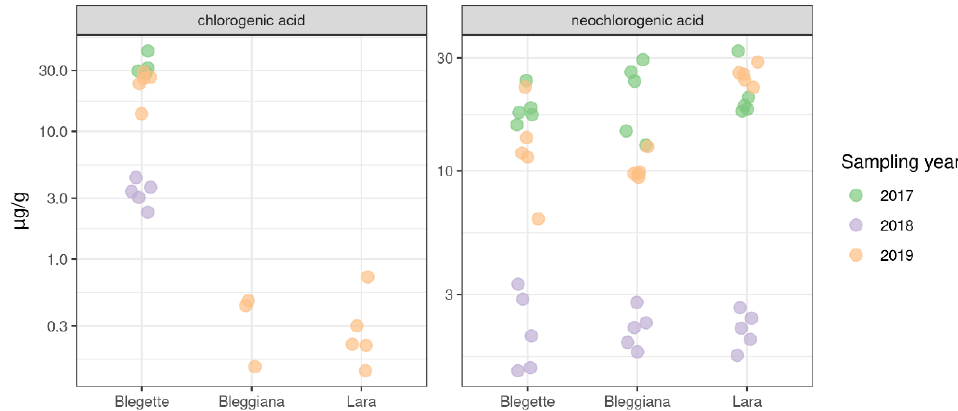
Figure 5. Dot plot of chlorogenic and neochlorogenic acid concentration in the samples of three walnut cultivars (‘Bleggiana’, ‘Blegette’ and ‘Lara’) collected in three different harvesting seasons (2017, 2018, 2019). Quantification was obtained by ultraperformance liquid chromatography coupled with tandem mass spectrometry (UPLC-MS/MS) in the whole raw kernel. Chlorogenic acid seems to be absent in cultivars ‘Bleggiana’ and ‘Blegette’, being undetected in 2017 and 2018, and just very close to the detection limit in 2019. Conversely, the concentration levels of neochlorogenic acid are similar in all the three cultivars and consistent across the harvesting seasons.